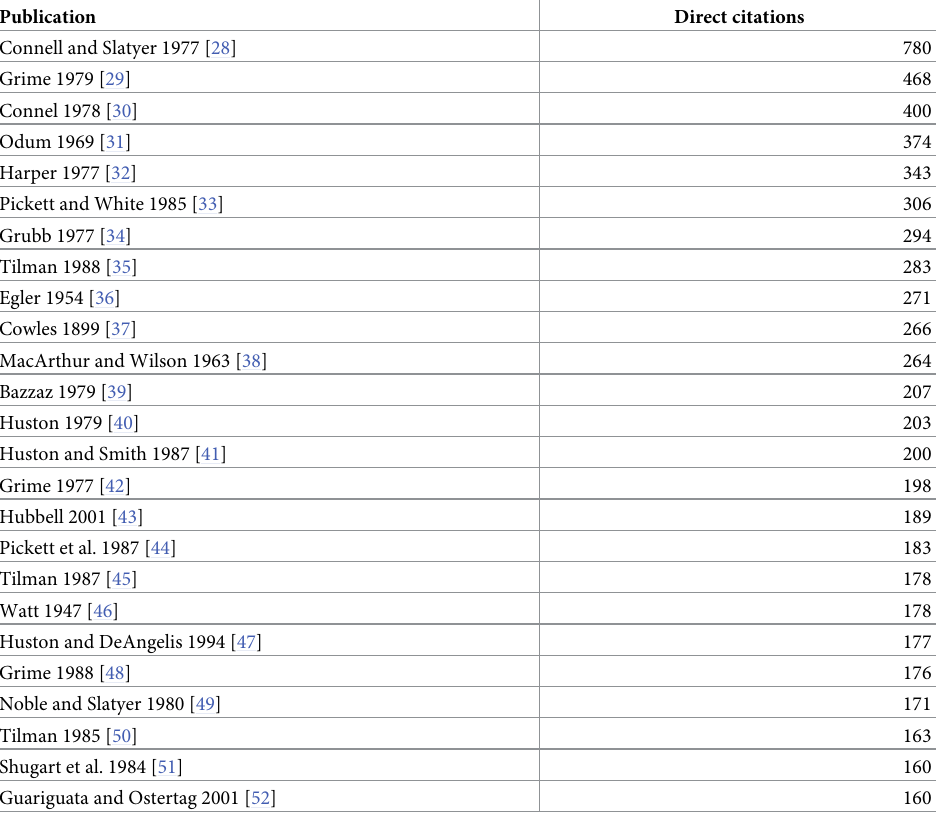
Table 1. List of relevant publications sorted by number of